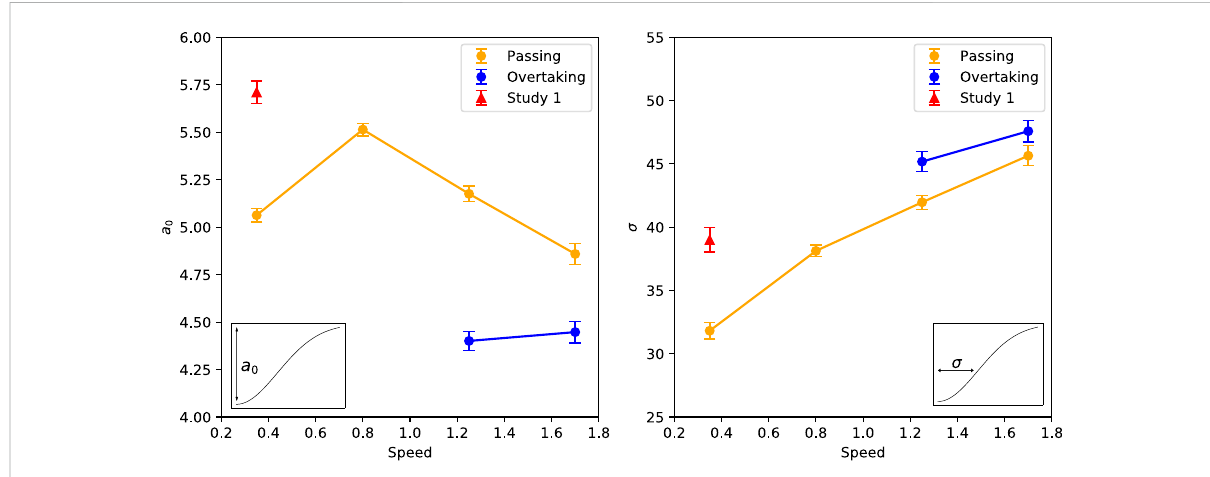
FIGURE 11 Parameters a 0 and σ plottedwiththemovementspeedoftherobot. a 0 representstheheightand σ representsthewidthoftheinvertedGaussian describing the relationship between comfort and passing distance (see insets). In the fi gure the parameters of Experiment 1 (red triangles) and Experiment 2 for both passing (yellow circles) and overtaking (blue circles) are plotted. Error bars represent Standard Error.